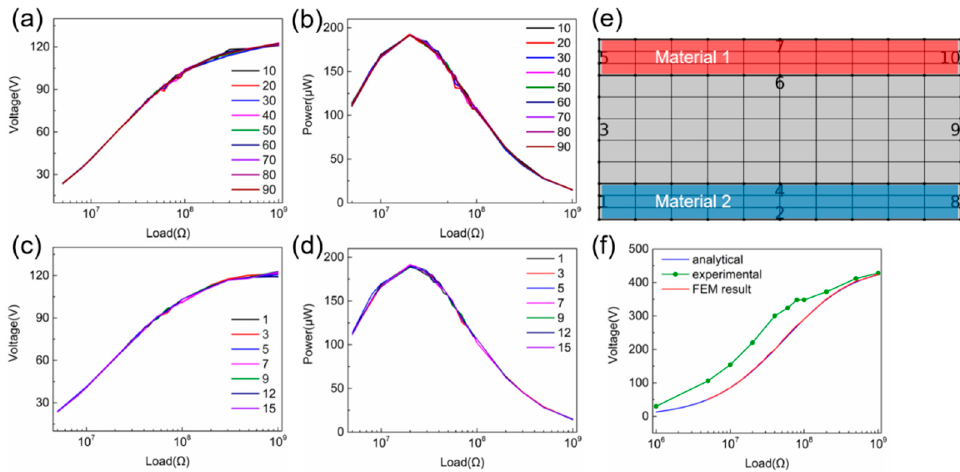
Figure 4. Simulated ( a ) voltage and ( b ) power output with increasing mesh density in horizontal boundaries; simulated ( c ) voltage and ( d ) power output with increasing mesh density in vertical boundaries. ( e ) The mapped mesh of contact mode TENG with vertical (1, 3, 5, 8, 9 and 10) and horizontal boundaries (2, 4, 6, and 7). ( f ) Comparison of experimental data and simulated results based on the dynamic FEM model, analytical model.